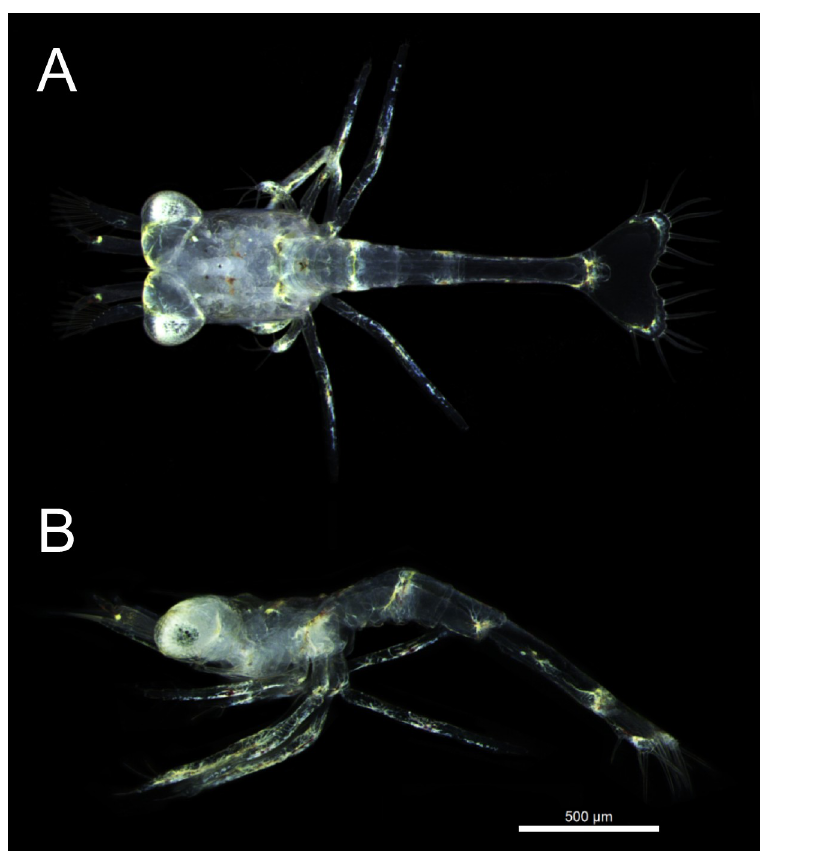
Fig 5. Newly hatched Lysmata vittata (Stimpson, 1860) zoea I. (A) Dorsal view. (B) Lateral view.